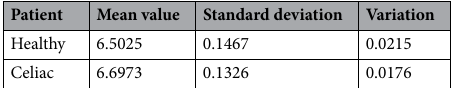
Table 10. Interpretation of the variation of entropy